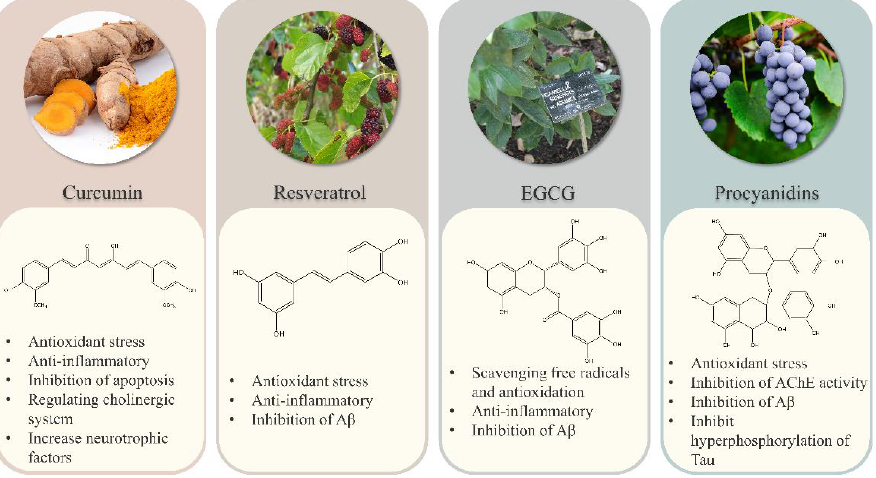
Figure 6. Mechanisms of action of curcumin, resveratrol, proanthocyanidins, and EGCG in AD treatment: Curcumin, resveratrol, proanthocyanidins, and EGCG alleviate the pathological symptoms of AD mainly through antioxidant stress, anti-neuroinflammation, inhibition of A β production and inhibition of AchE.